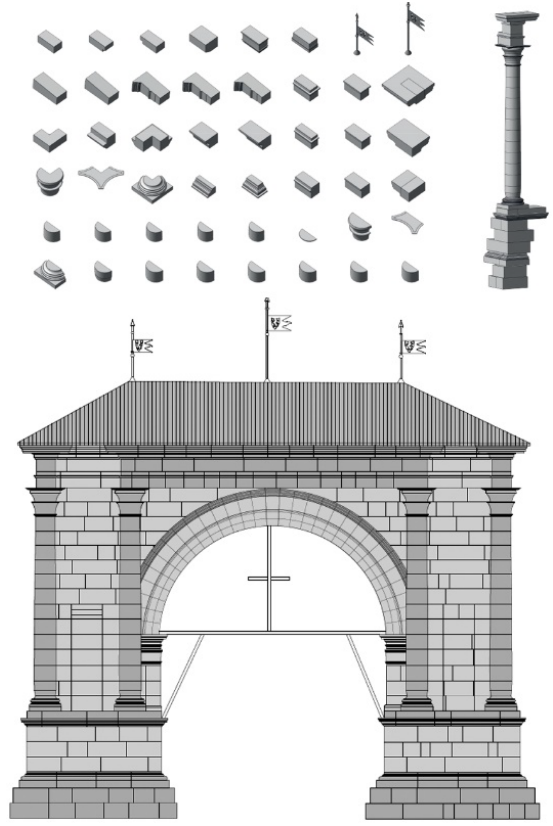
Figure 3: (top) All of the geometric families of ashlars, (bottom) west elevation with the evidence of each single element.